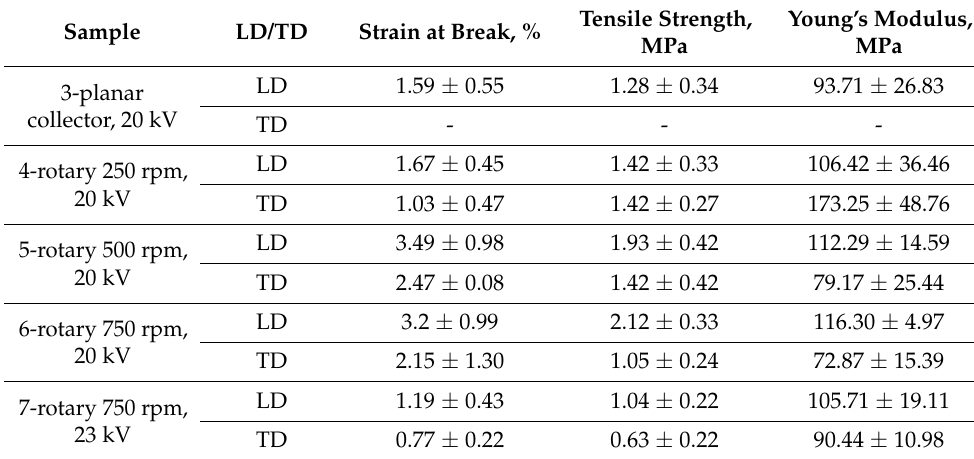
Table 5. Mechanical properties of samples